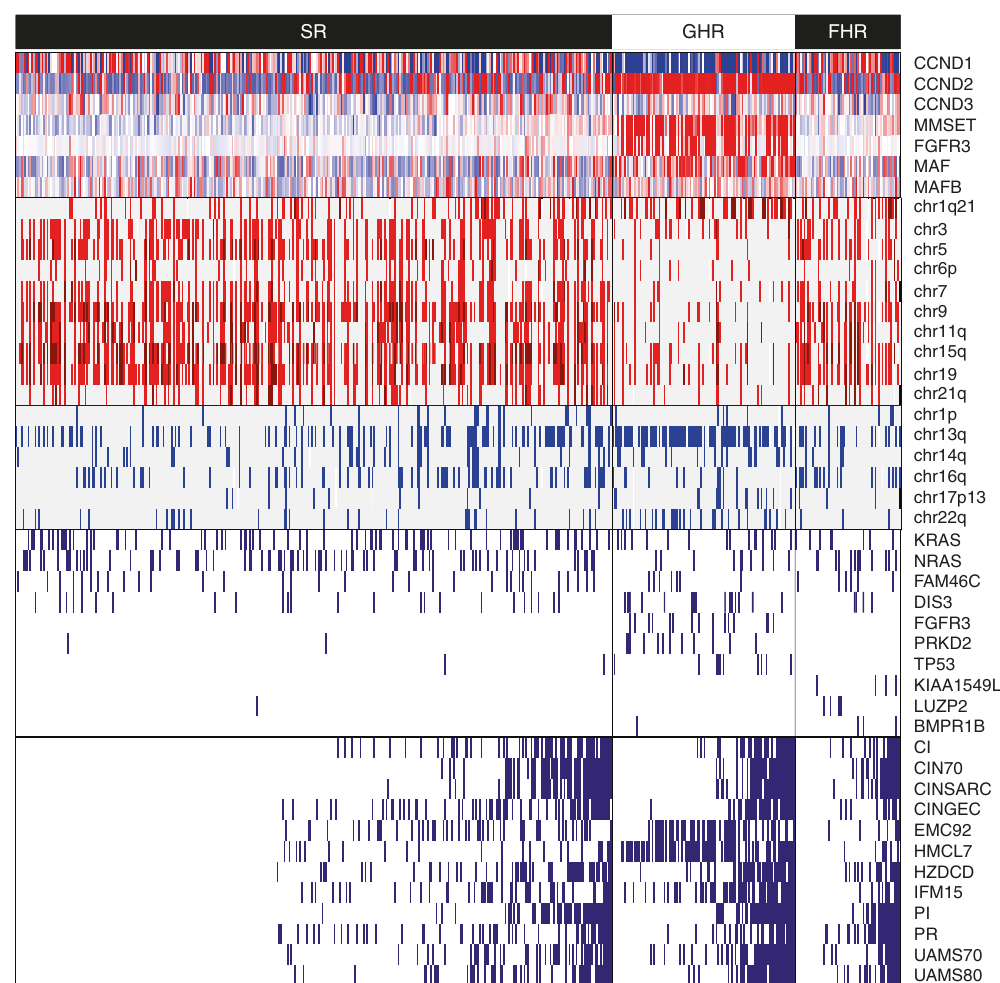
Fig. 3 Composite heat map combining gene expression, copy number aberration, mutation, and gene expression signatures. Top panel (CCND1, CCND2, CCND3, MMSET, FGFR3, MAF, MAFB) shows the median-normalized gene expression pro fi les of important TC class marker genes. For each gene, expression above/below the median level is indicated as red/blue, and the median level is indicated as white. The second panel comprises chr1q21, chr3, chr5, chr6p, chr7, chr9, chr11q, chr15q, chr19, chr21q which displays gain of the respective chromosomal regions. Single copy gain is indicated as red and two or more copy gain is indicated as dark red. The GHR group clearly shows the dominance of non-hyperdiploid cases while the SR and FHR groups show prevalence of hyperdiploid cases. The third panel comprises chr1p, chr13q, chr14q, chr16q, chr17p13, chr22q which exhibits loss of respective chromosomal regions. Single copy loss is indicated as blue and two-copy loss is indicated as dark blue. The GHR group clearly shows the dominance of chr13q deletion, possibly indicating the involvement of RB1. The fourth panel comprises KRAS, NRAS, FAM46C, DIS3, FGFR3, PRKD2, TP53, KIAA1549L, LUZP2, and BMPR1B which shows presence of NS mutations for the respective genes. KRAS, NRAS, FAM46C, and DIS3 are known to be frequently mutated in